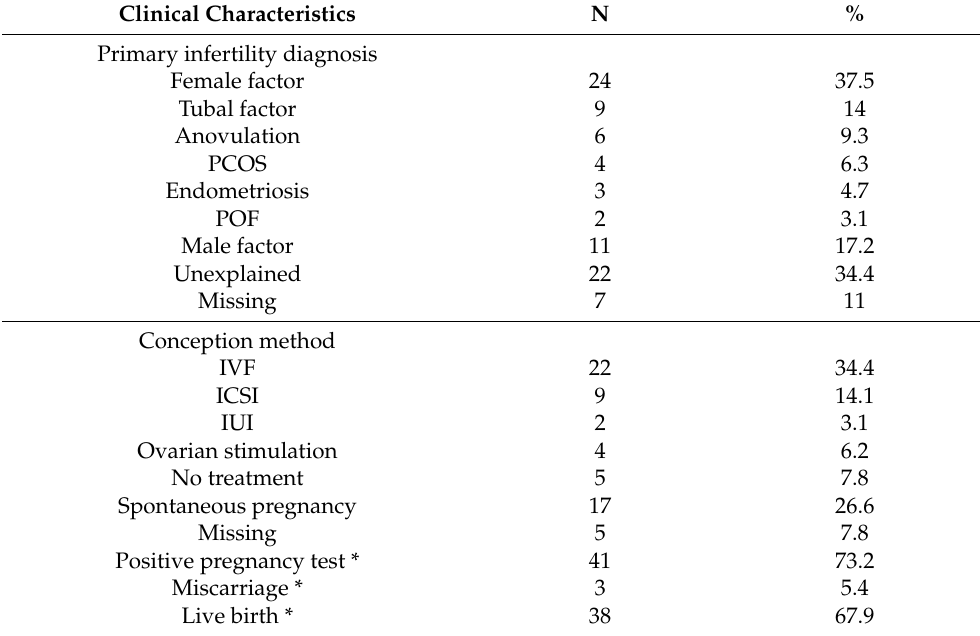
Table 2. Distribution of clinical factors for infertile couples and infertility treatment